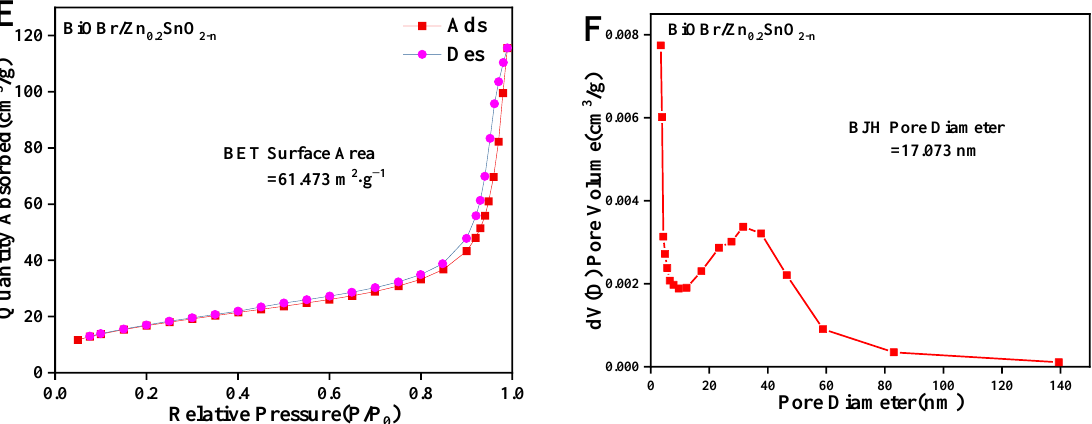
Figure 4. Adsorptions and desorption isotherms ( A , C , E ) and BJH pore size distributions ( B , D , F ) for BiOBr, BiOBr/SnO 2 and BiOBr/Zn@SnO 2 . Table 1. Specific surface area and average pore sizes. Materials